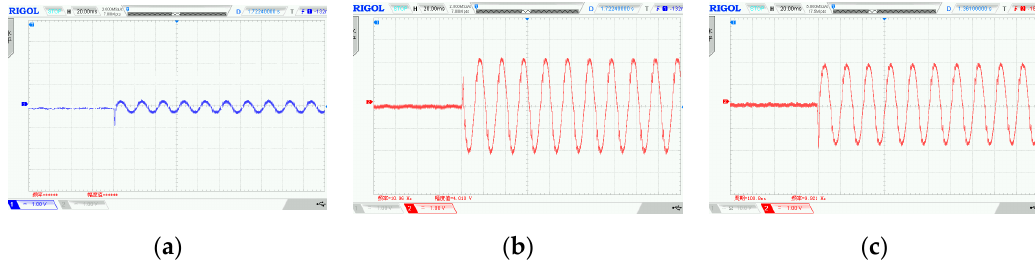
Figure 15. Experimental results of zero-sequence currents when a single-phase earth fault occurs on the end of the first feeder: ( a ) first feeder; ( b ) second feeder; and ( c ) third feeder.